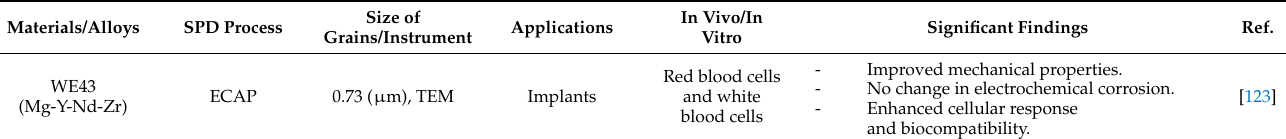
Table 4. Summary of studies on UFG/NG magnesium as produced by